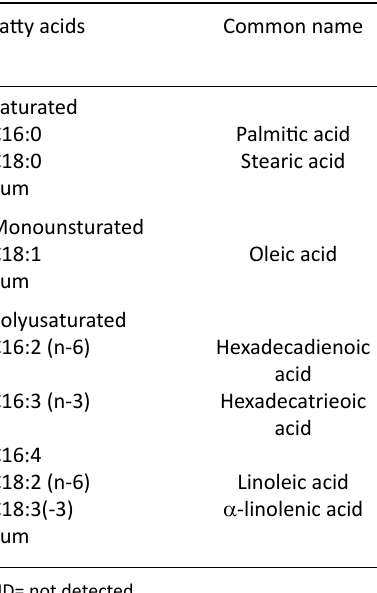
Table 2. Fatty acid profile (FA) (percentage to total fatty acids) of freshwater microalgae Fatty acids